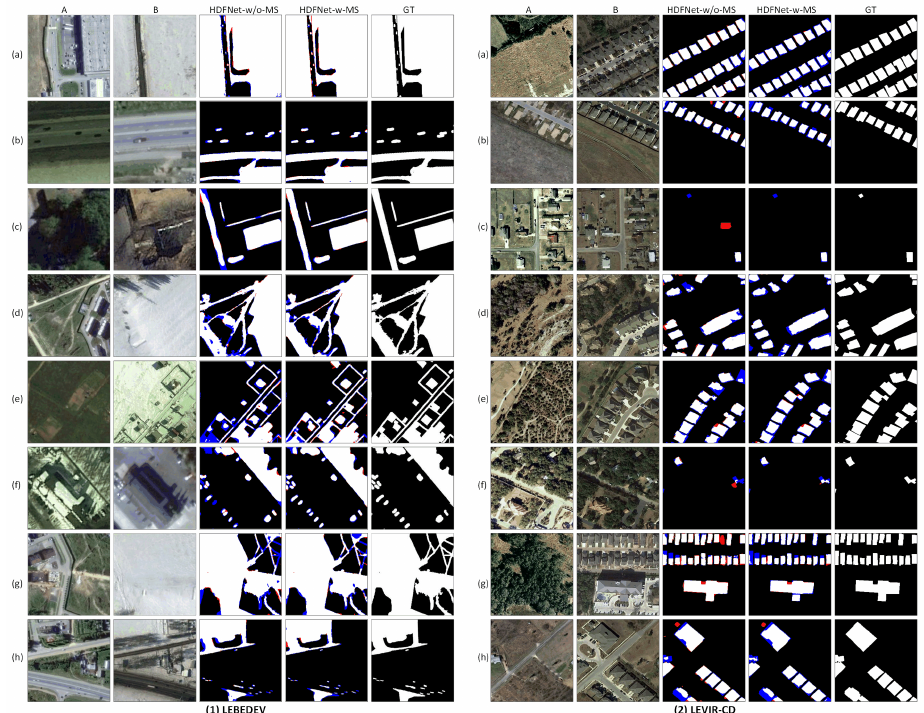
Figure 11. Qualitative ablation study on with/without multilevel supervision (presented as ‘MS’) of HDFNet on both datasets, represented in (1) LEBEDEV and (2) LEVIR-CD. We select samples ( a – h ) from each dataset. White indicates the changes detected correctly. Black indicates the no change detected correctly. Red indicates the false alarms. Blue indicates unpredicted